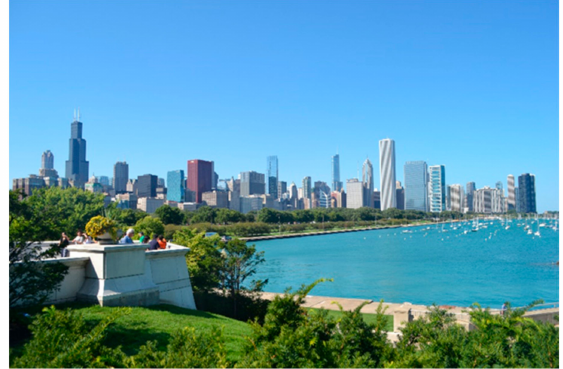
Figure 13. In addition to o ff ering a variety of indoor exhibits, the Museum Campus area provides excellent vistas on the city’s remarkable skyline.